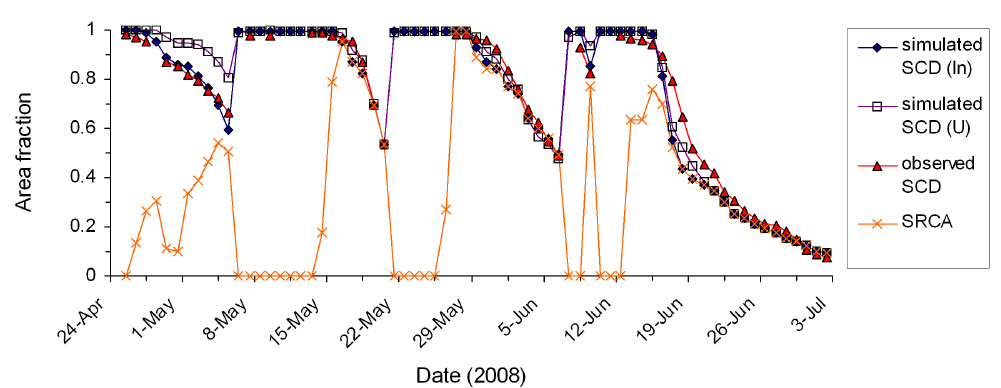
Fig. 7. Simulated basin-scale SCD curve and SRCA over the Upper Middle Creek Basin for the spring period of 2008. SCD curves were derived based on inhomogeneous melt (In), and from uniform slope-based melt (U) as in Figs. 5 and